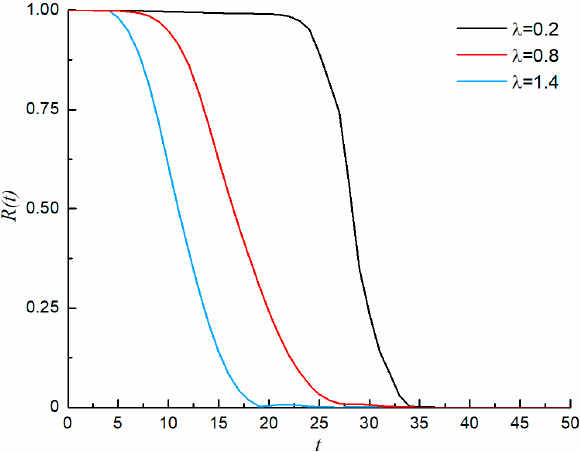
Figure 4. Reliability curves with varying arrival rates of the shock process.